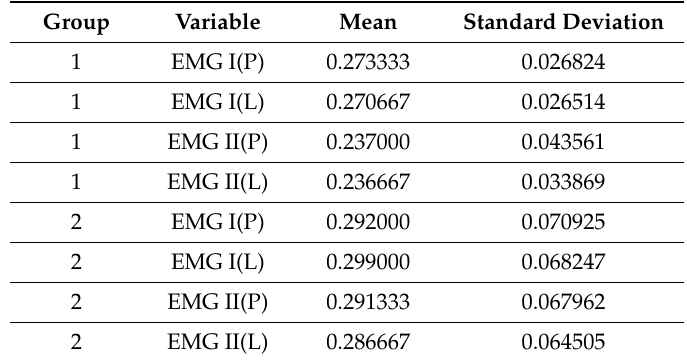
Table 8. Main descriptive statistics.